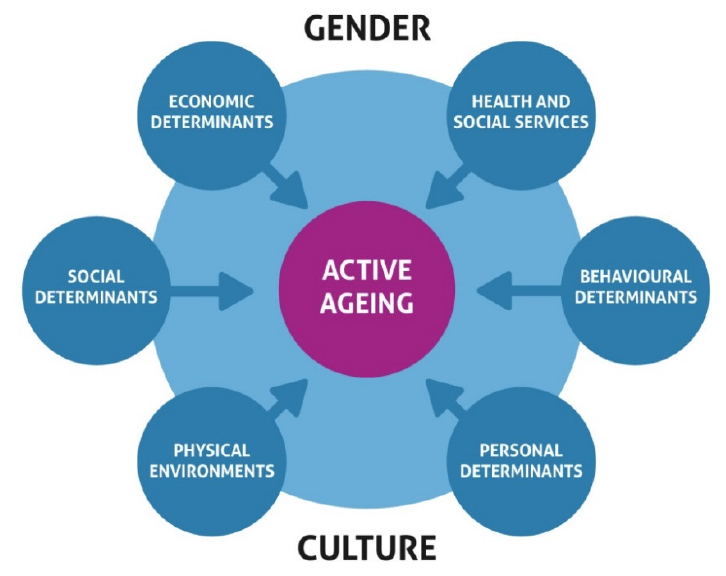
Figure 1. Determinants of active ageing. Source: [7]